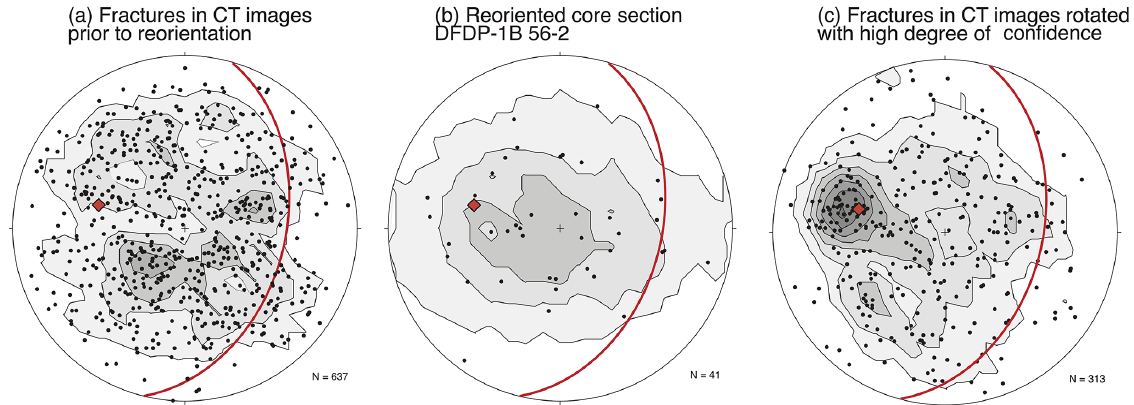
Figure B1. Stereoplots to tests the confidence in reorientations applied to rotate DFDP-1 CT scan fracture orientations into geographic coordinates. Red great circle and diamond in each plot represent the plane and pole to the Alpine Fault orientation measured in DFDP- 1B. Plotted with Kamb contours with intervals of 2 standard deviations. (a) Orientation of fractures shown in Fig. 5a before rotation, (b) orientation of reoriented fractures within a single core section (DFDP-1B 56-2), and (c) orientation of fractures in CT images from core sections that were oriented with a high degree of confidence with BHTV